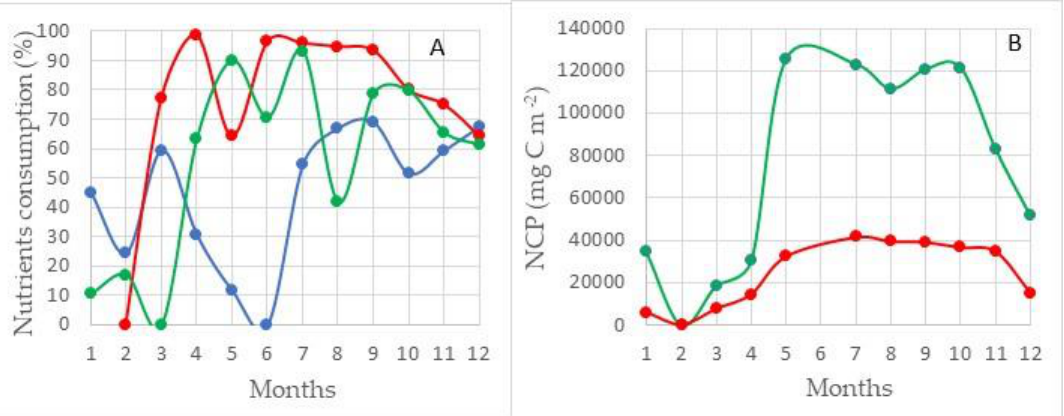
Figure 11. Annual cycle of primary production and nutrient consumption ( A ) and primary produc- tion ( B ) in Region IV; ( A ) is the consumed part of the nutrient supply in the process of photosynthe- sis (blue: mineral phosphorus, red: mineral nitrogen, green: silicon). ( B ) primary production (green: NCP Si ; red: NCP N ).